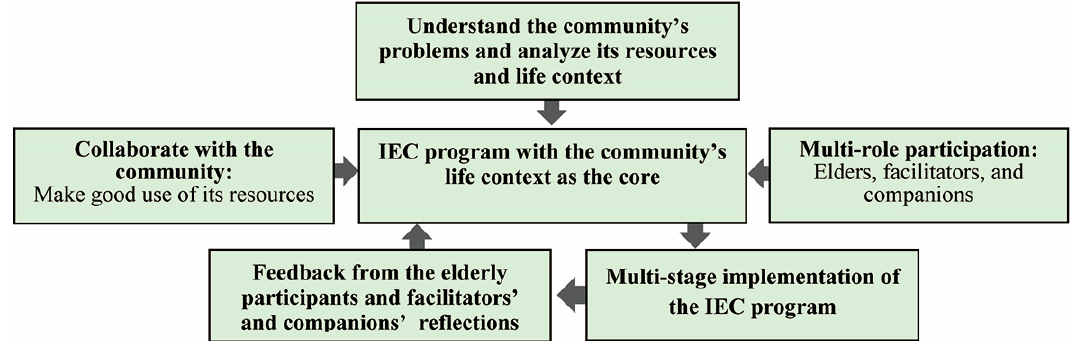
Figure 4. Model for applying IEC workshops to promote sustainable CA.